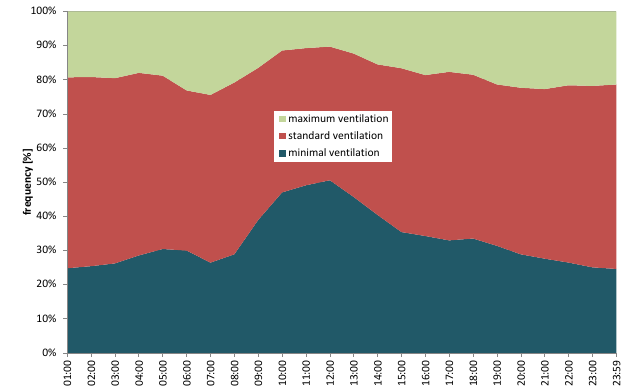
Figure 10. Mean distribution of the three air flow levels in the ven- tilation system during the day for one